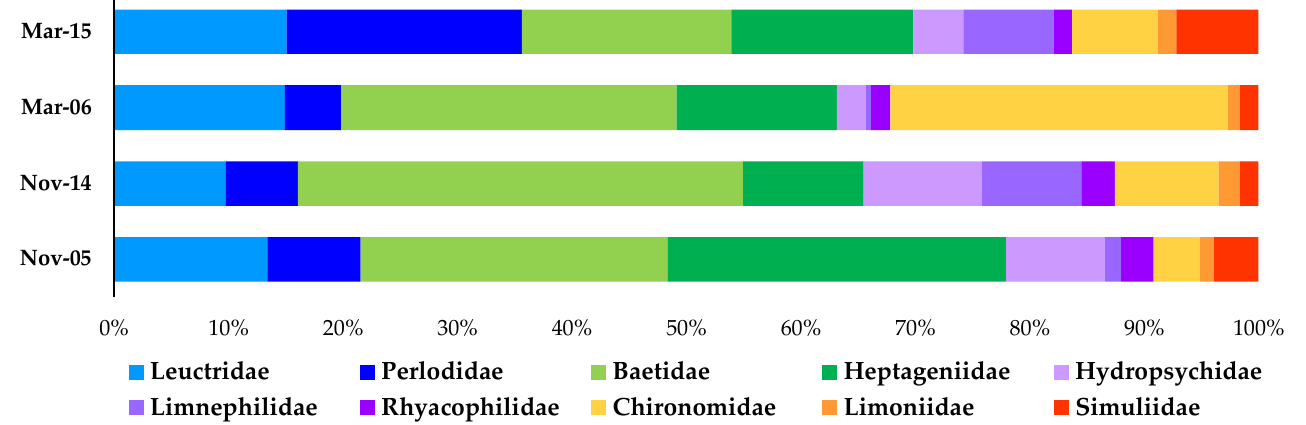
Figure 3. Relative abundance of the main 10 families of benthic macroinvertebrates collected in the Roasco Stream before and after the implementation of minimum flows and controlled sediment flushing operations (data from [23,24]). Plecoptera families are blue-colored, Ephemeroptera are green-colored, Trichoptera are purple-colored and Diptera are orange-colored.